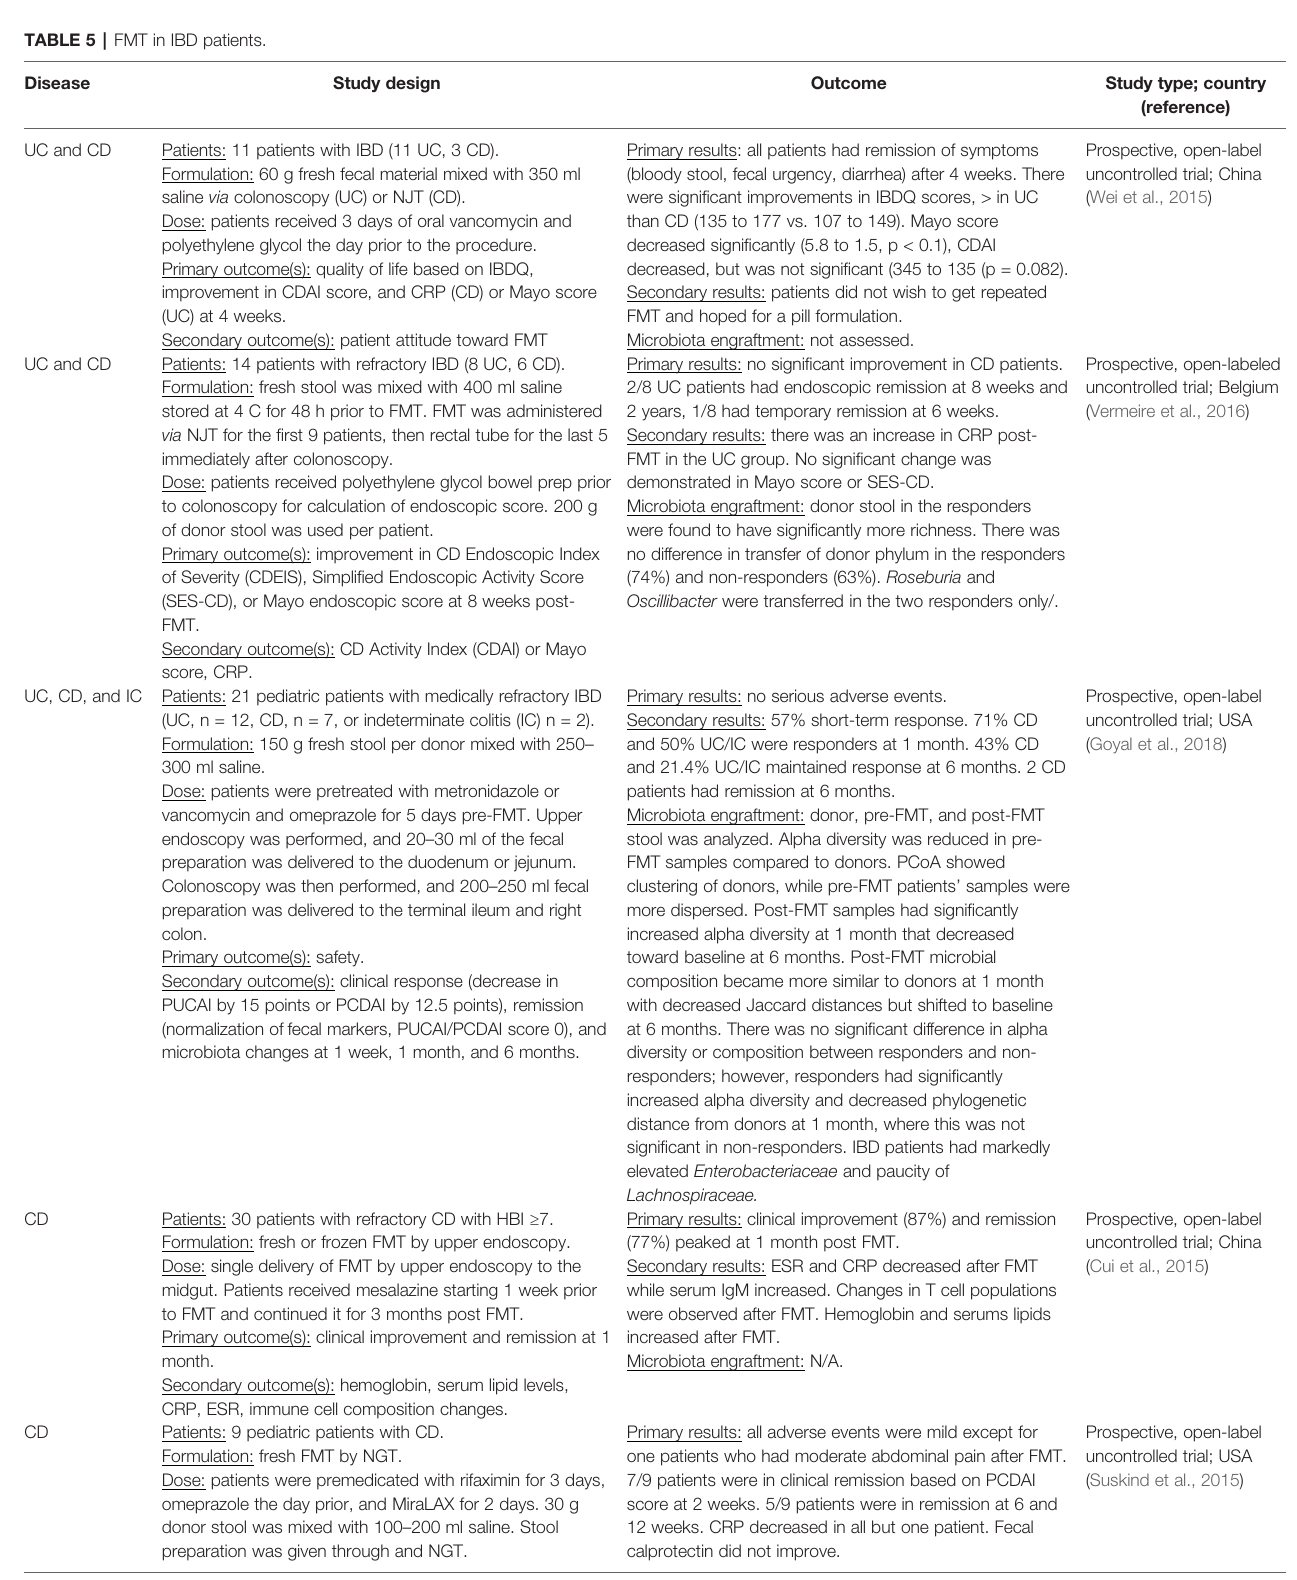
TABLE 5 | FMT in IBD patients.